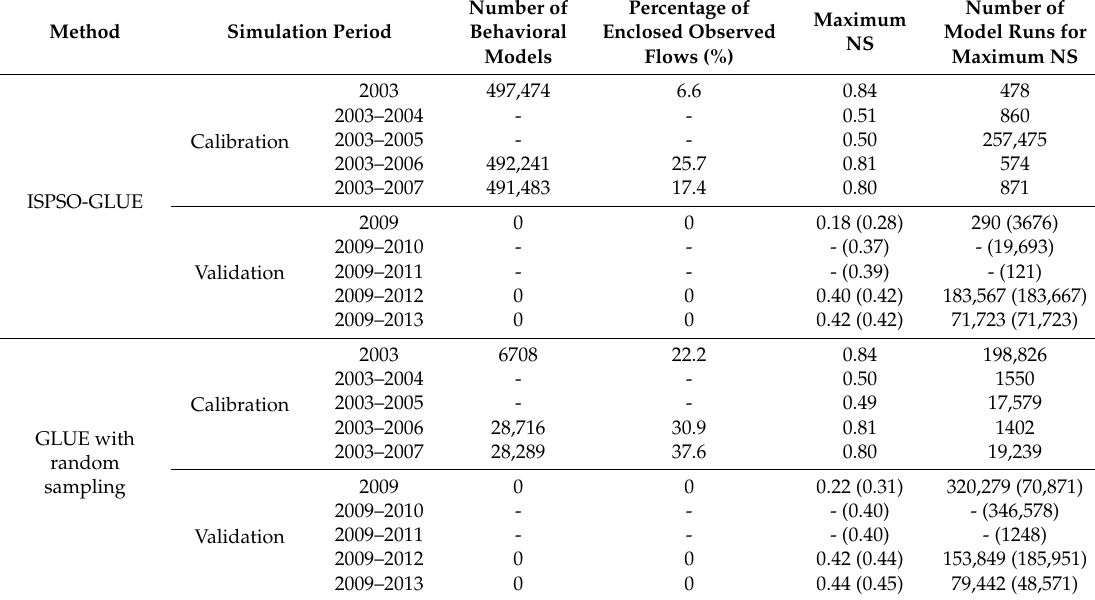
Table 2. Number of behavioral models, percentage of enclosed observed flows, maximum NS, and number of model runs for the maximum NS. The threshold value for behavioral models is a NS coefficient of 0.6. Dashes indicate that there were no behavioral models for the calibration period and no simulations were performed for the validation period. For comparison purposes, all models including behavioral and non-behavioral models were run to calculate the maximum NS coefficient in the validation periods, which are displayed within